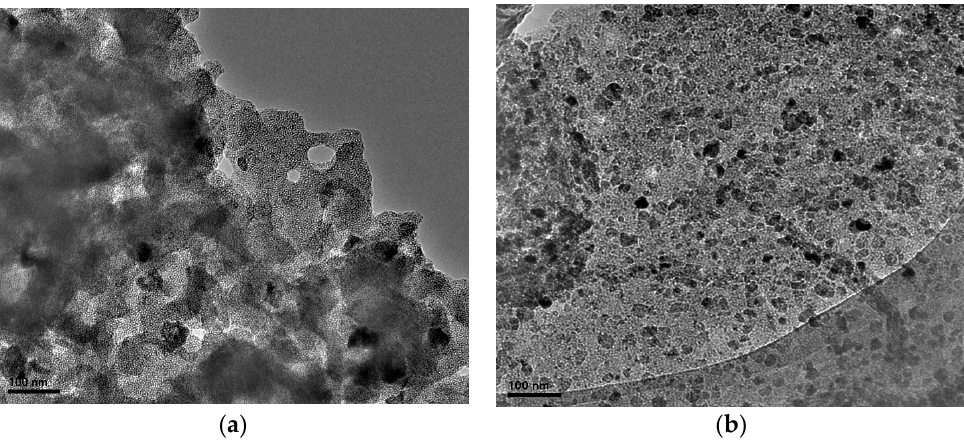
Figure 6. TEM analysis of the fresh catalyst, ( a ) 5%Ni/MCM-41 and ( b ) 2%Ga5%Ni/MCM-41. The locations with darker contrast in the images in Figure 6a are ascribed to the Ni particles [36].